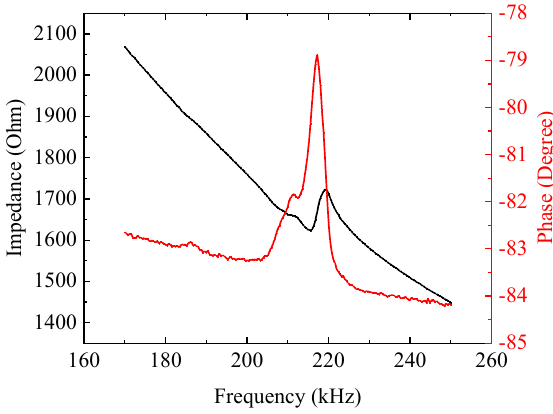
Figure 5. Impedance curve of our air-coupled CMUT.